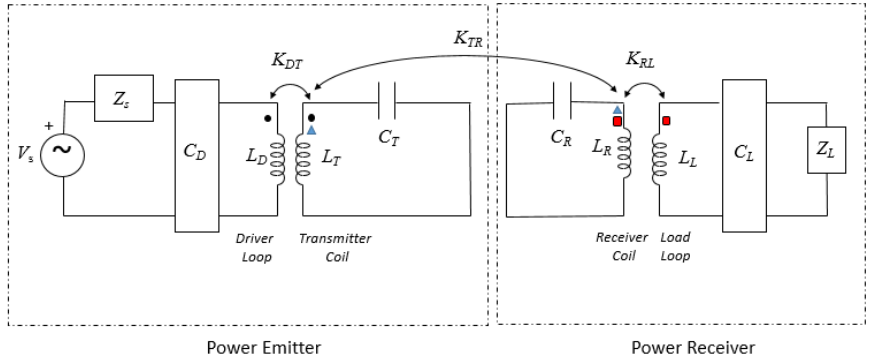
Figure 1. Scheme of an indirect-fed link for SCMR system with generic compensation systems in the driver and in the load.